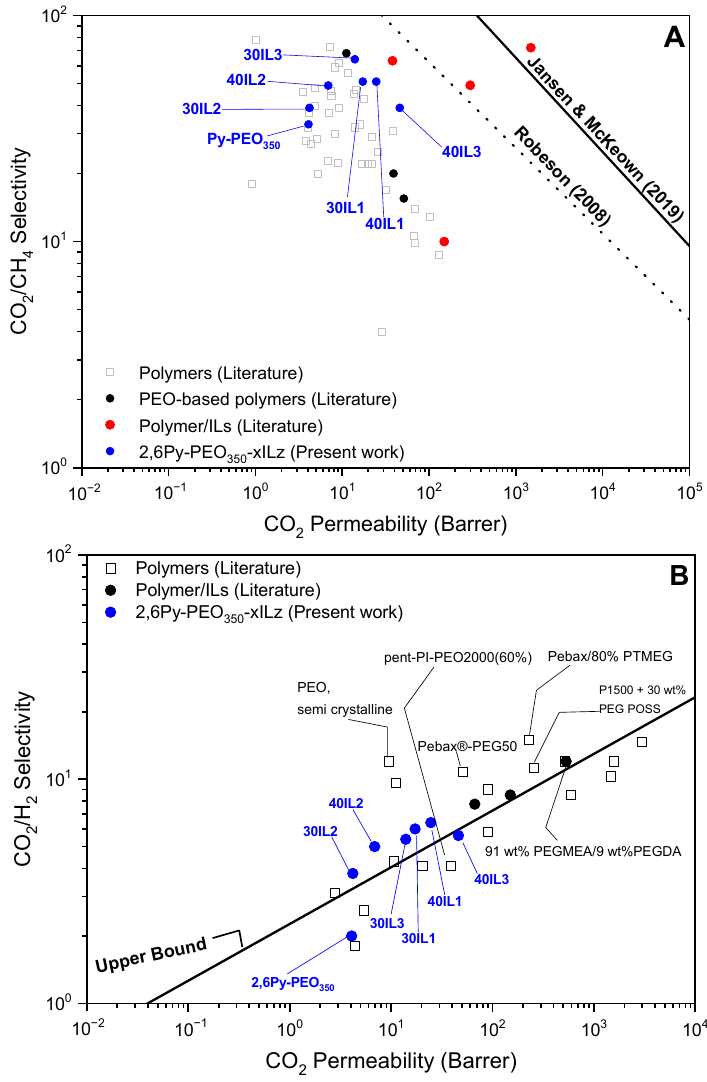
Figure 6. Permeability–selectivity upper bound plots of 2,6Py-PEO 350 and composite membranes (blue circles) for ( A ) CO 2 /CH 4 and ( B ) CO 2 /H 2 selectivity. The 2008 and 2019 upper bounds for CO 2 /CH 4 (35 °C) were adapted from refs. [22,51]. The upper bound for CO 2 /H 2 (25 °C) was adapted from refs. [52,53]. The rest of the data points were taken from refs. [7,52,54–64].